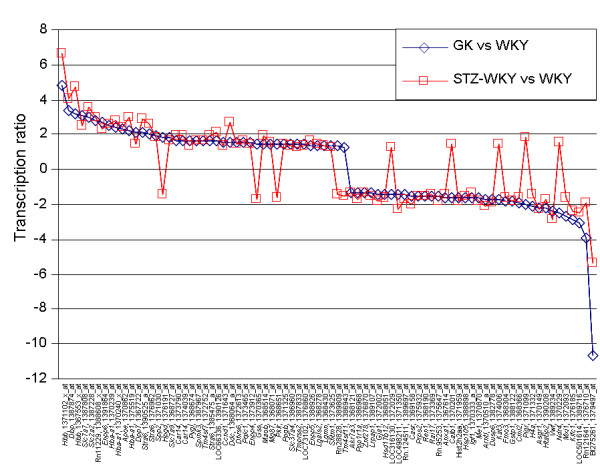
Patterns of transcription for genes consistently differentially expressed between diabetic rats (GK and STZ-WKY) and WKY controls. Genes are listed along the X axis with both Affymetrix probe set names and either symbols for known genes or accession number references for EST sequences. Genes are ranked from the highest (left) to the lowest (right) changes in transcription ratio in the GK vs WKY comparison.